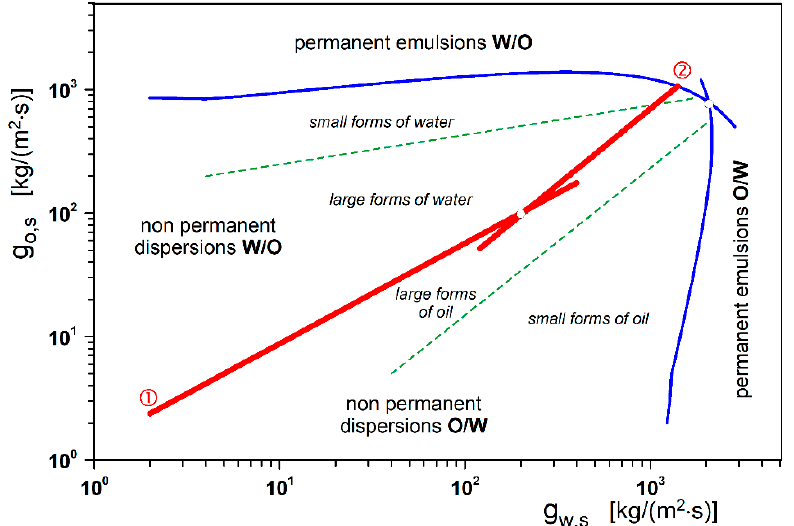
Figure 1. Simplified map with two-phase liquid–liquid flow structures with boundaries of phase inversion (red lines) and conditions responsible for generation of non-permanent emulsions (blue lines).